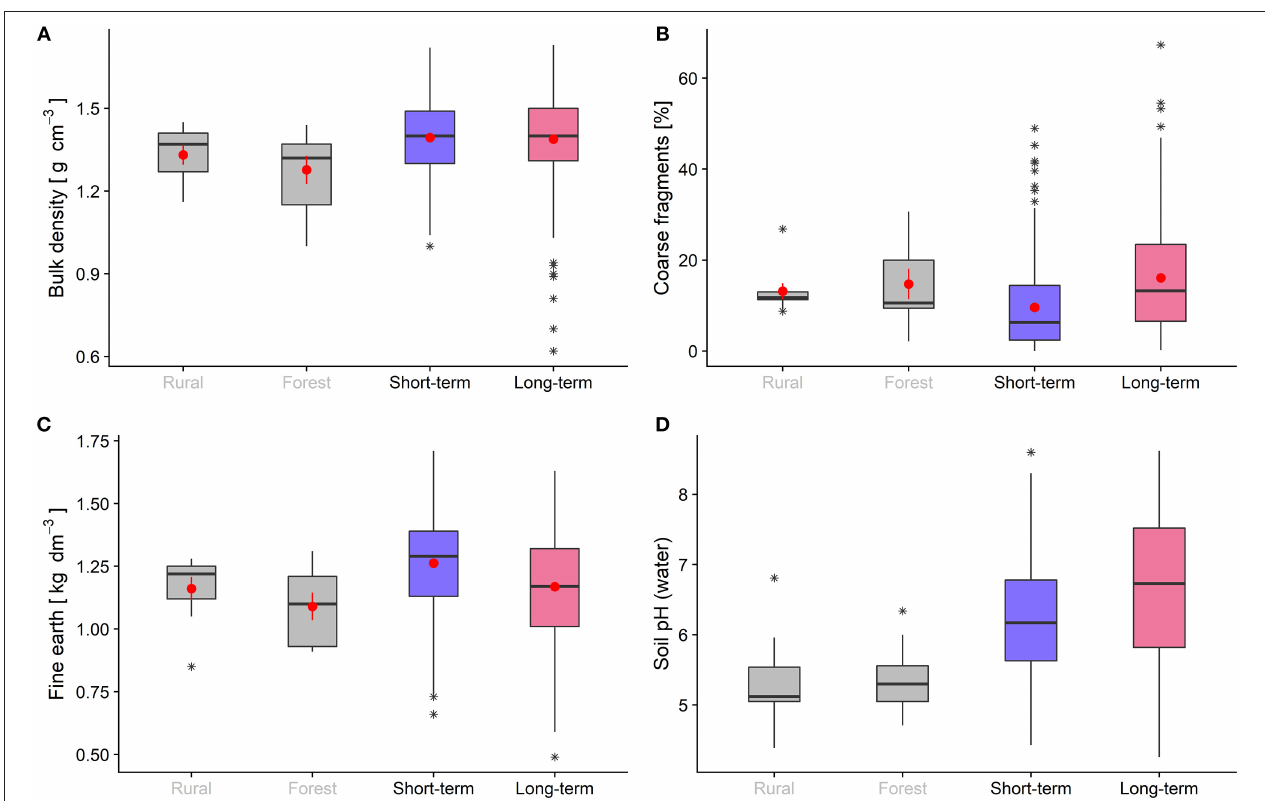
FIGURE 4 | Boxplots for (A) bulk density, (B) coarse fragment content, (C) fine earth content, and (D) soil pH (water), of rural, forest and urban soils. Statistical analysis focused on relative differences between short-term and long-term urban soils. Arithmetic means (red points), standard errors (red whiskers), medians (bars), ranges (whiskers) and outliers (asterisks) are